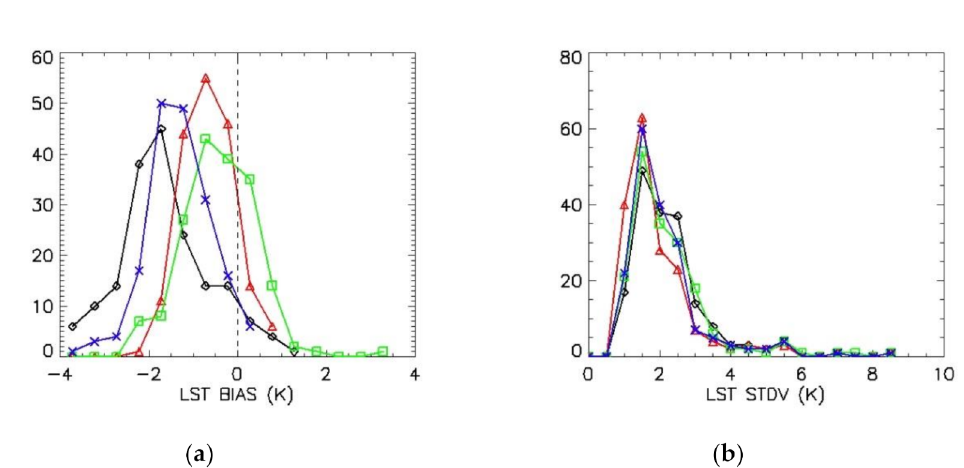
Figure 6. Histogram of the bias ( a ) and standard deviation ( b ) values for all BELMANIP sites for the drifted time series (black diamonds) and the corrected time series C0, C1, and C2 (red triangles, green squares and blue crosses, respectively).